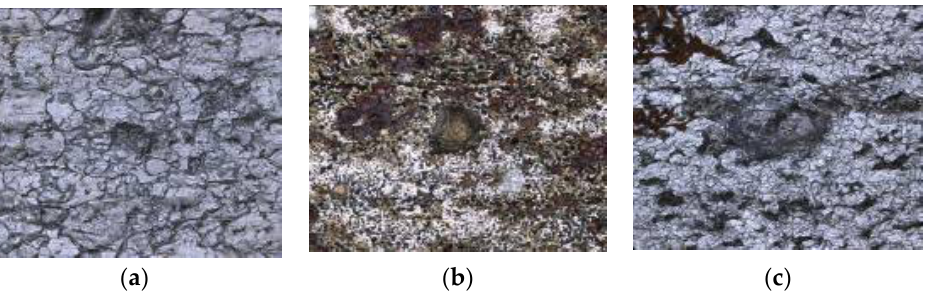
Figure 4. Scanning electron micrographs of pits (×25 times): ( a ) Cl − = 60,000 mg/L; ( b ) Cl − = 110,000 Figure 4. Scanningelectronmicrographsofpits( × 25times): ( a )Cl − =60,000mg/L;( b ) Cl − = 110,000 mg/L; mg/L; ( c ) Cl − = 150,000 mg/L. ( c ) Cl − = 150,000 mg/L.